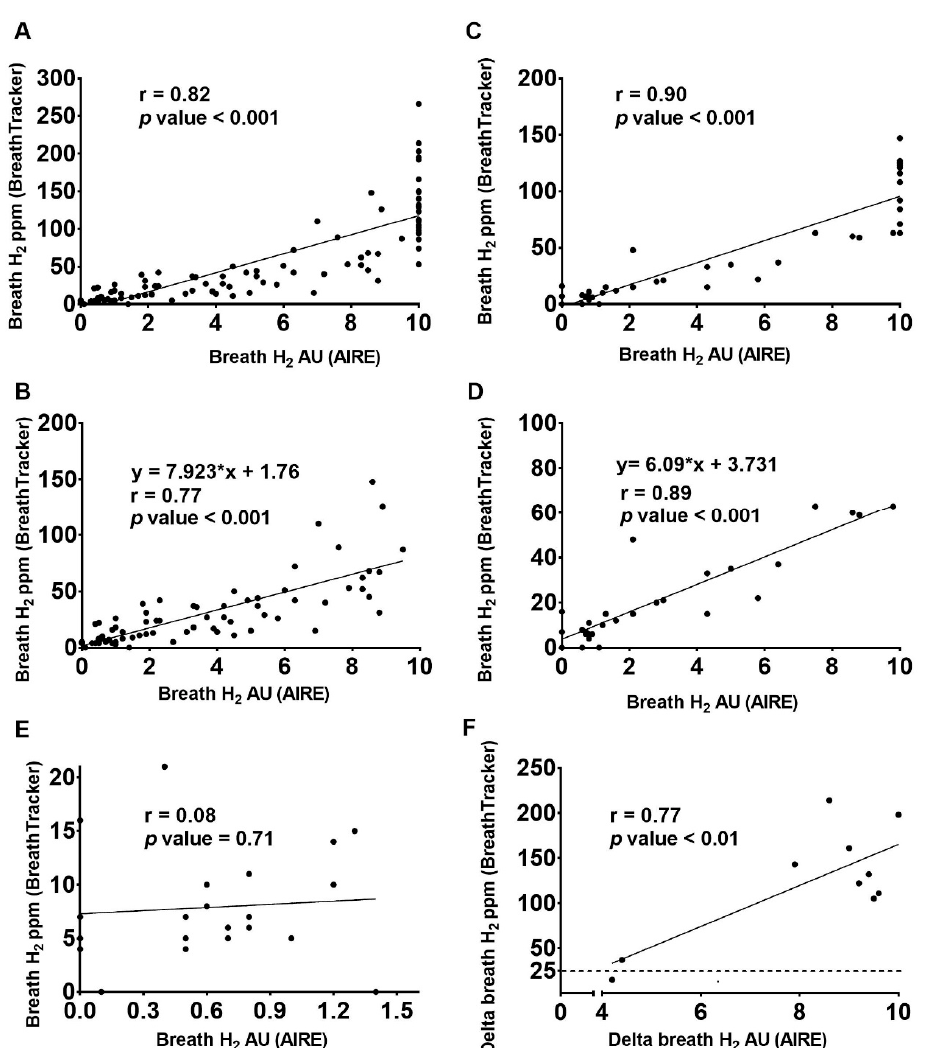
Figure 1. Scatterplots with simple linear regression line showing the relationship between H 2 readings from the AIRE (x-axis) and BreathTracker (y-axis), after lactose ingestion with all readings ( A ); after lactose ingestion with AIRE scores of 10 removed ( B ); after milk ingestion with all readings ( C ); after milk with AIRE scores of 10 removed ( D ); at baseline before lactose or milk ingestion ( E ); and the max delta after lactose ingestion ( F ). Figure 1A–D represent raw H 2 readings i.e., the baseline is not